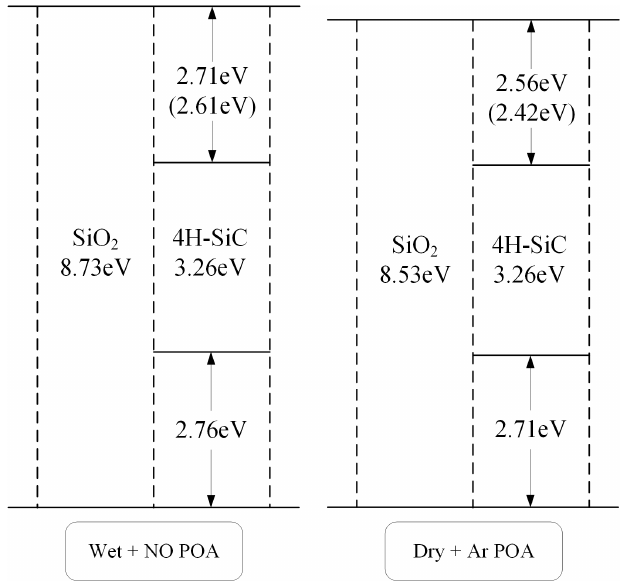
Figure 6. Energy band alignments of the SiO 2 /SiC structures for the different samples.